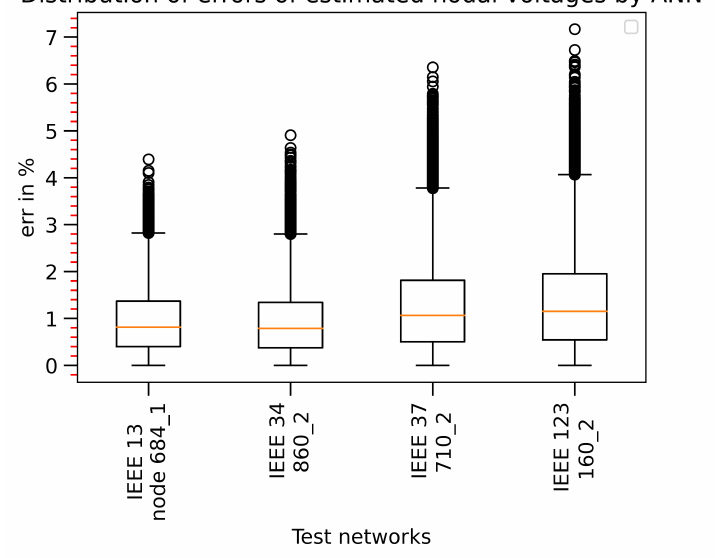
Figure 9. Distribution of percentage errors (absolute amounts) of nodal voltage phasor magnitudes for nodes with the highest errors obtained in Step